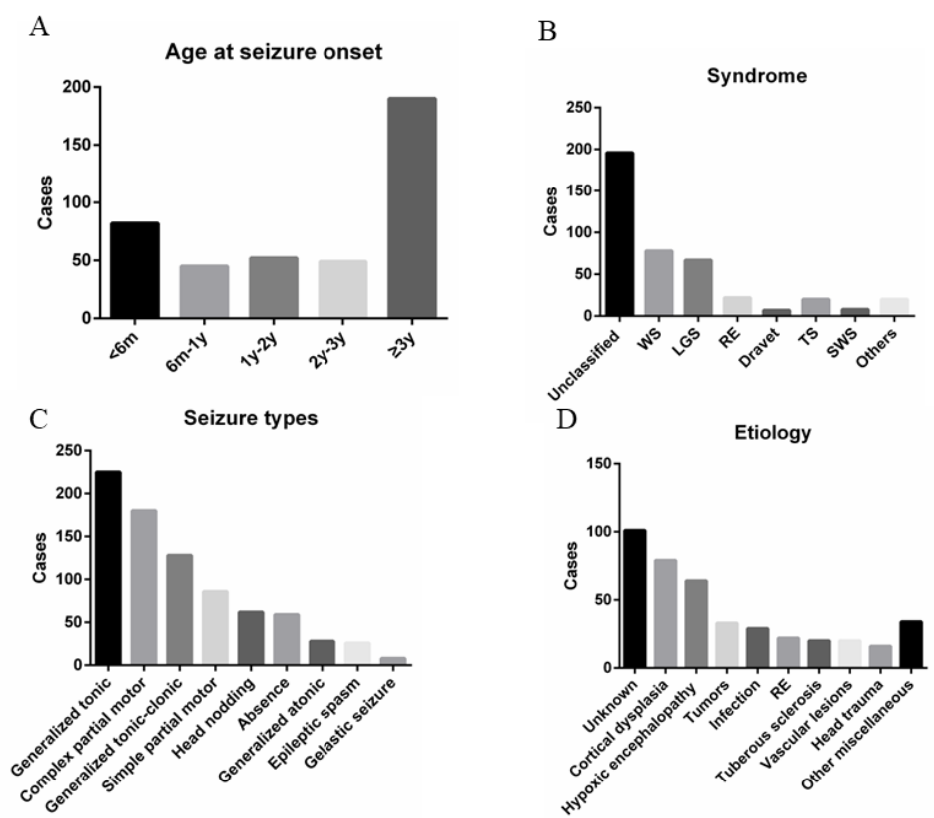
Figure 2. ( A – D ) summarized the clinical characteristics of pediatric patients with drug-resistant ep- ilepsy in terms of age at seizure onset, epileptic syndrome, seizure type, and etiology, respectively.